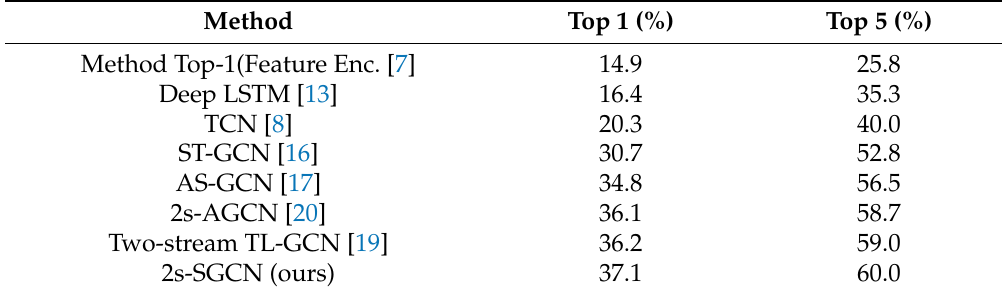
Table 6. Comparisons of the validation accuracy with state-of-the-art method on the Kinetics- Skeleton